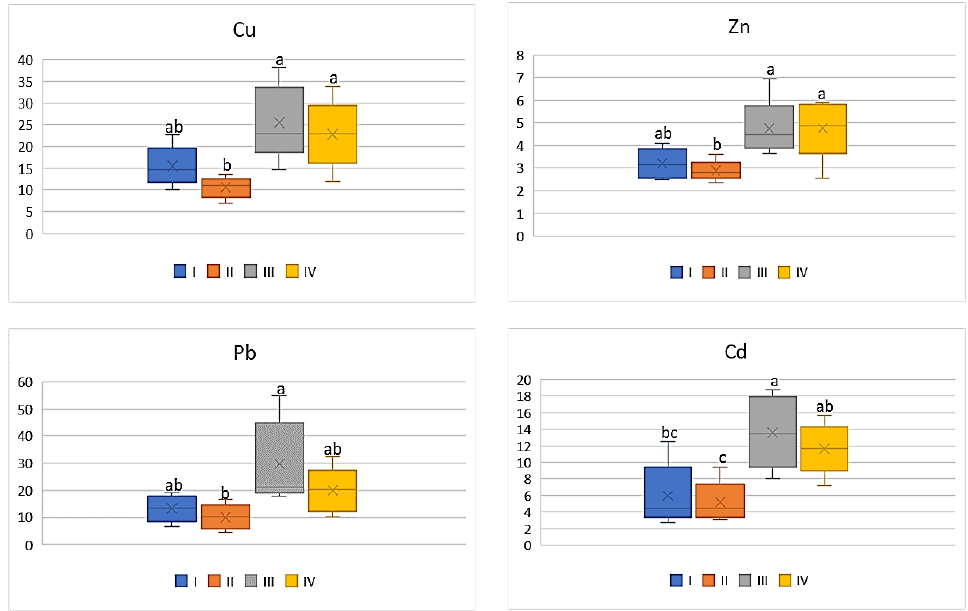
Figure 7. HRI values for carrot depending on the metal and study zones. The same letters mean no significant differences between the values.